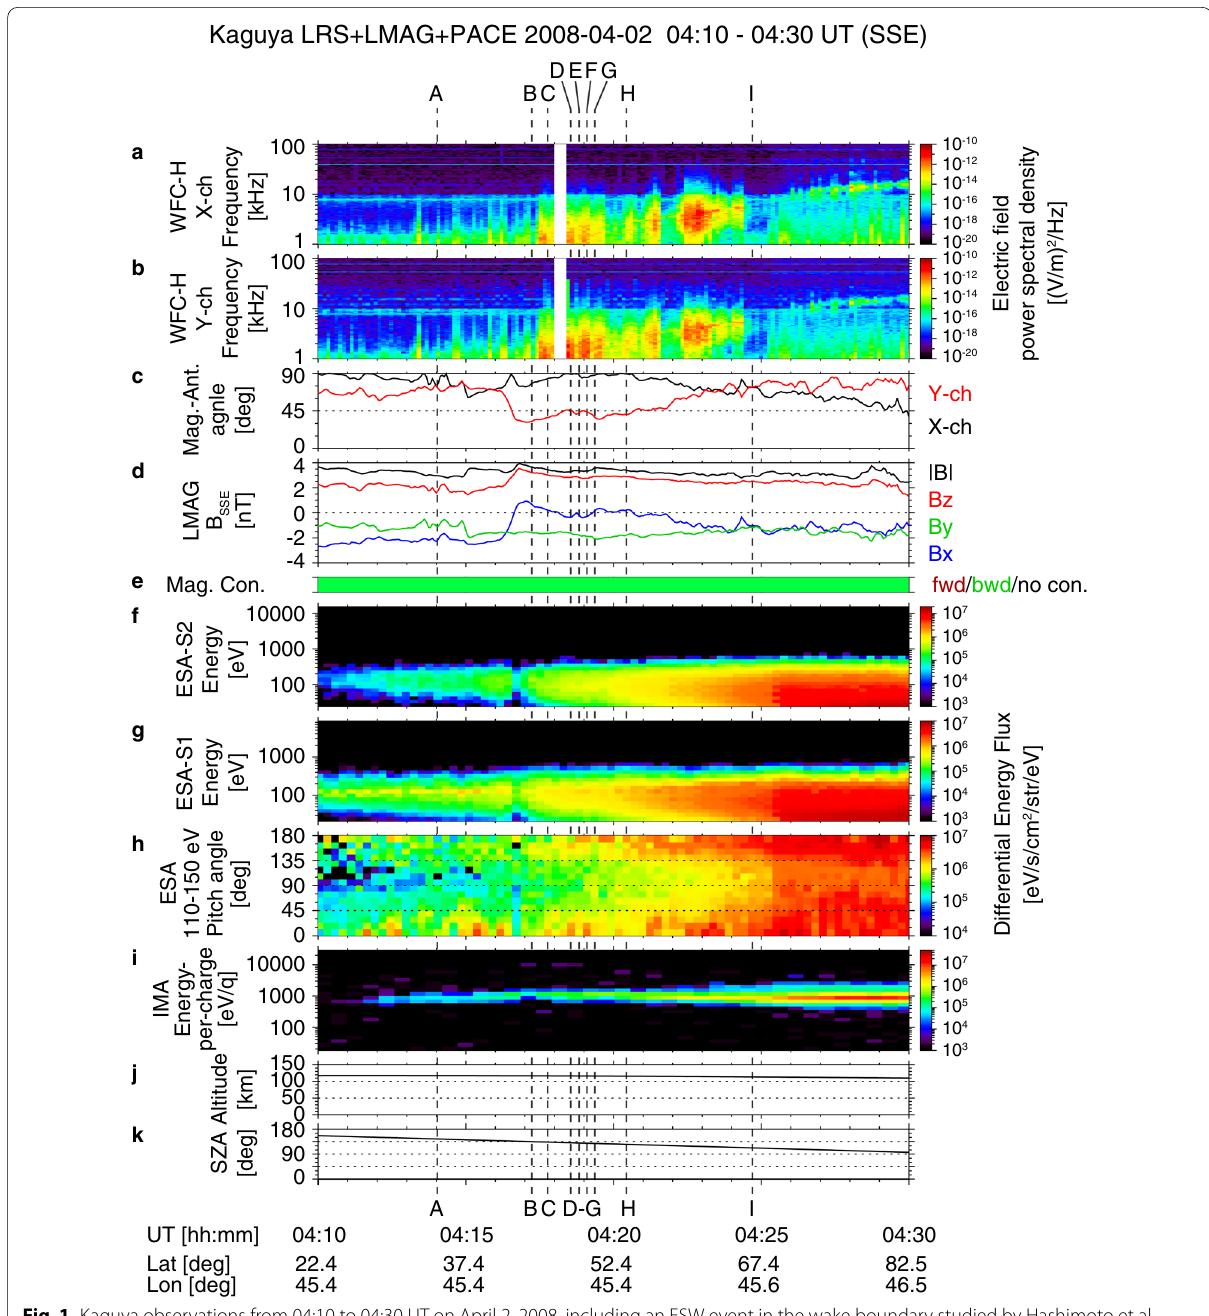
Fig. 1 Kaguya observations from 04:10 to 04:30 UT on April 2, 2008, including an ESW event in the wake boundary studied by Hashimoto et al. (2010). From the top, a frequency–time spectrogram of electric field from X-channel of WFC-H; b frequency–time spectrogram of electric field from Y-channel; c angles between the local magnetic field and X-channel and Y-channel antennas; d magnetic fields in the SSE coordinate system; e magnetic connection to the lunar surface estimated by a linear extrapolation of the magnetic field at the spacecraft (brown: forward connection (not applicable), green: backward connection, black: magnetically detached (not applicable)); f electron energy–time spectrogram from ESA-S2; g electron energy–time spectrogram from ESA-S1; h pitch-angle time spectrogram from ESA-S1 and ESA-S2; i ion energy–time spectrogram from IMA; j altitude of Kaguya from the average lunar surface; k solar zenith angle. Latitude and longitude at the footprint of the spacecraft in the ME coordinate system are presented at the bottom. The vertical dotted lines mark the times when electron pitch-angle distributions in Fig. 1 were